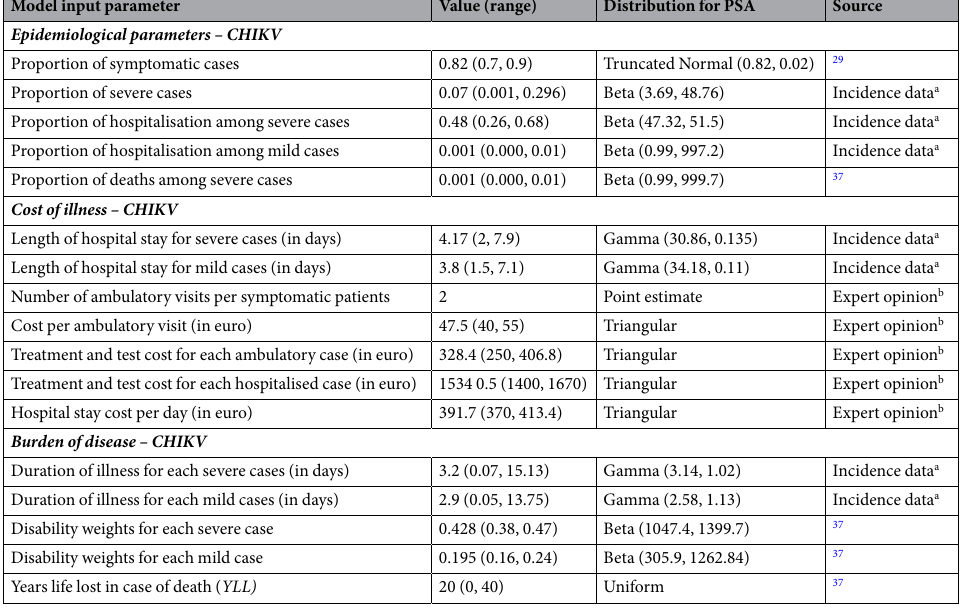
Table 1. Base case values and sampling distributions of cost of illness and DALYs loss parameters. a Incidence data were obtained by 34 . b Department of Infectious Diseases of the San Matteo hospital in Pavia,